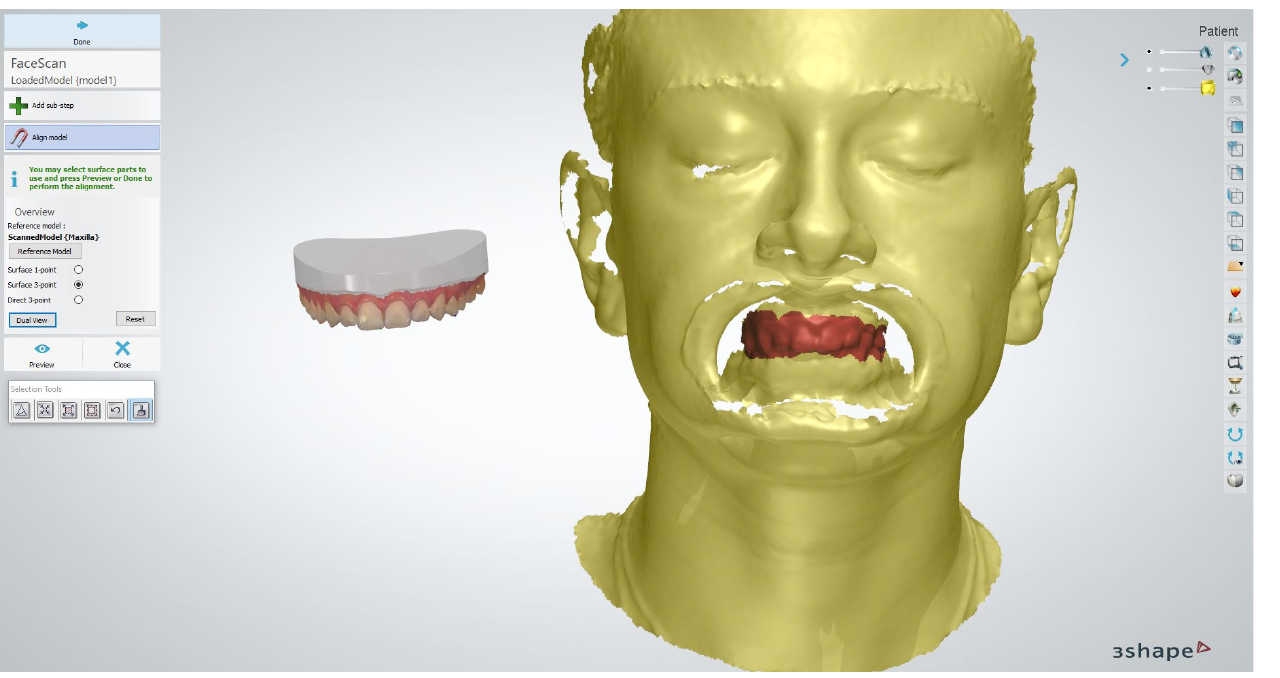
Figure 6. Matching the face scan with retractor with the face scan with closed mouth.